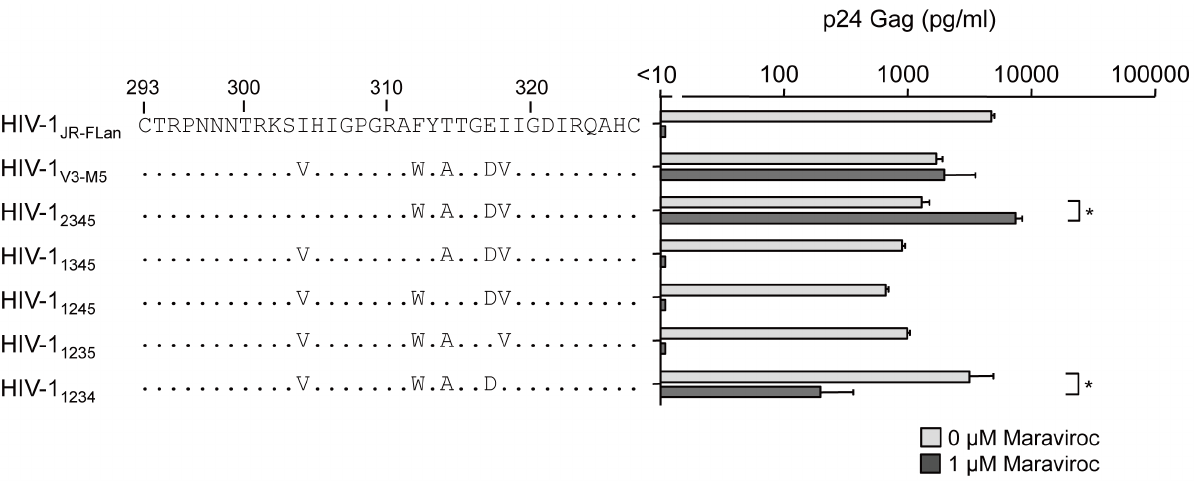
Figure 3. The effect of 1 m M of maraviroc on p24 Gag production in recombinant viruses containing four of the five amino acid substitutions. PM1/CCR5 cells (1 6 10 5 ) were infected with 10 ng p24 Gag for 3 h in the presence or absence of 1 m M maraviroc. On day 6 after infection, the amount of Gag in the supernatant was measured using HIV-1 p24 ELISA. The analysis was repeated three times; the error bars represent the S.D. of three replicates from one representative experiment. **, p , 0.01. Statistical significant difference was calculated by t test.